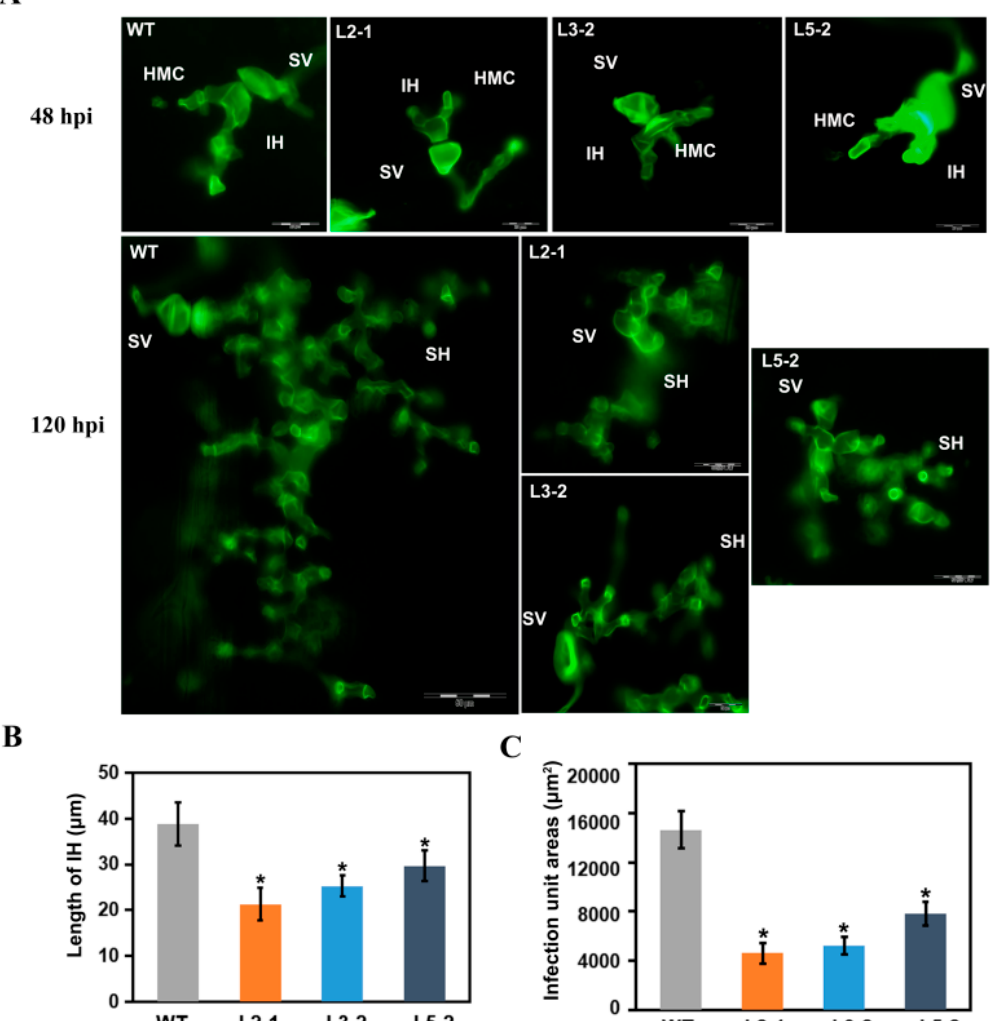
Figure 3. Histological determination of fungal growth in AtSAG101 transgenic plants. ( A ) Histological observation of fungal development. ( B ) Length of infection hyphae was significantly reduced. ( C ) A significant decrease in infection unit areas. WT, wild type plants; L2-1, L3-2 and 5-2, transgenic B.